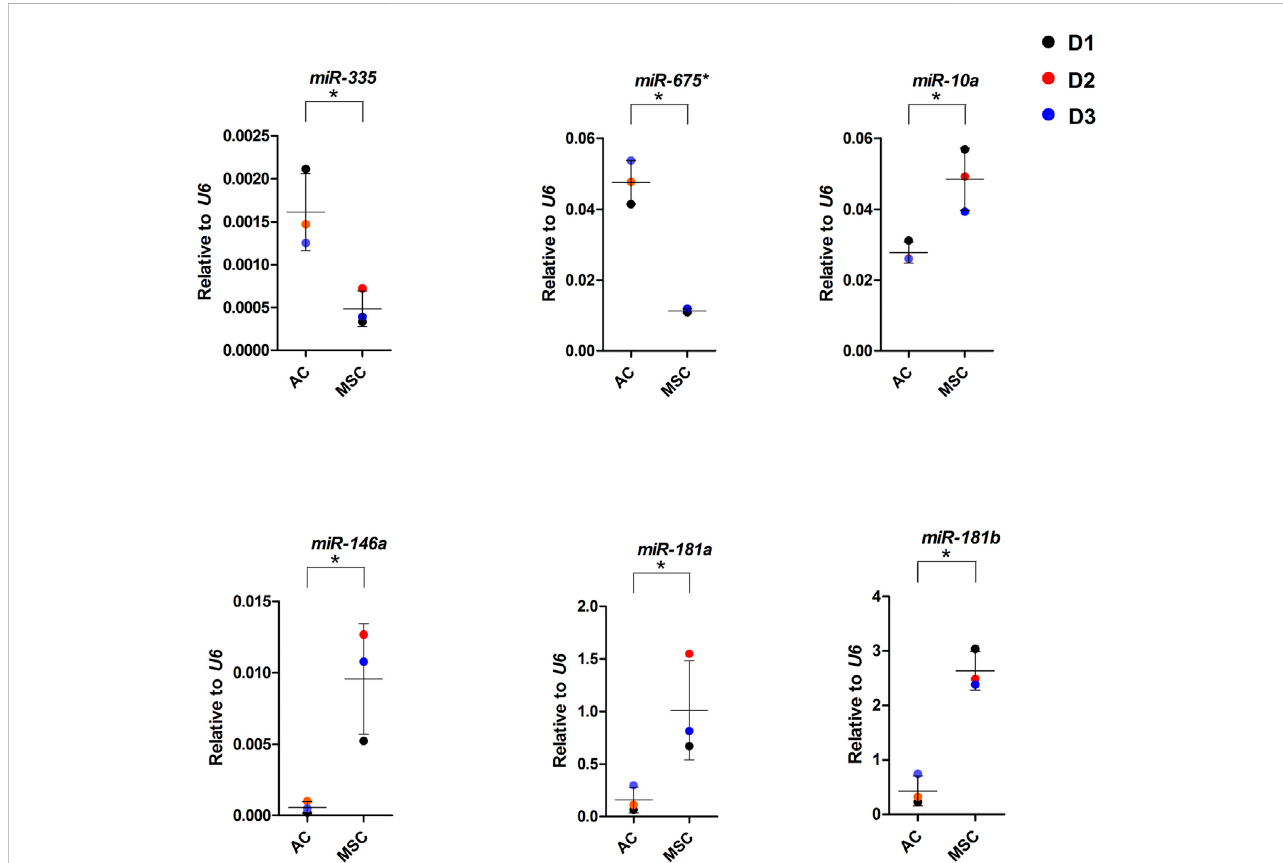
FIGURE 8 miRNA expression in AC and MSC discs. Real-time RT-qPCR analysis of cartilage discs after 4 weeks of differentiation. MiR-675* = miR-675-3p. Data presentedasdotplotdiagramwithmeanandSD;D1-D3(donor1 – 3).Student ’ s t -testwasusedforstatistics,and p ≤ 0.05wasconsideredsigni fi cant. N =3for each experimental group and DF =